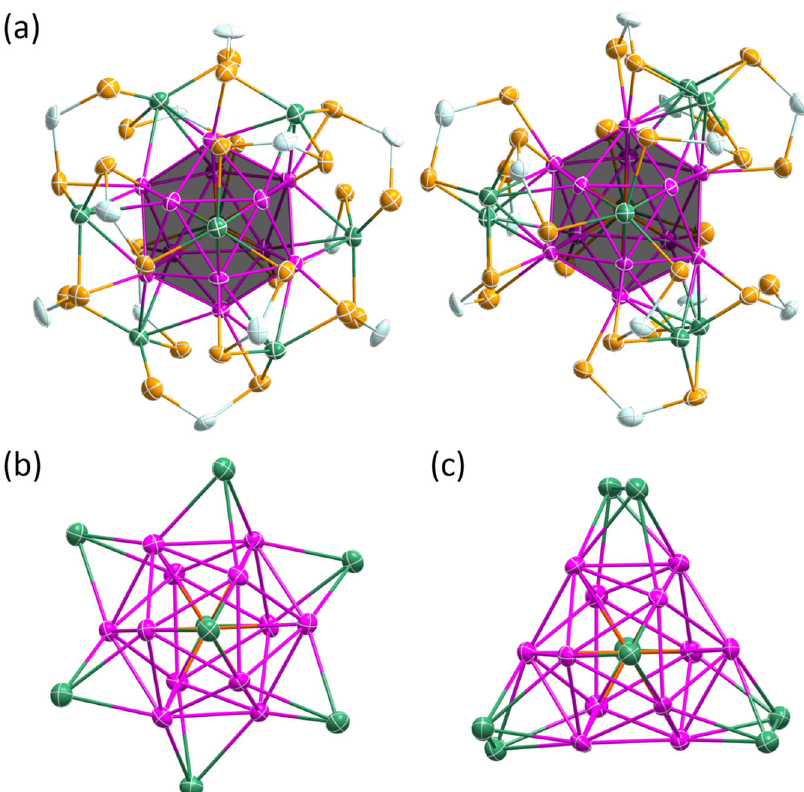
Fig. 5 The molecular structure of 3a and 3b. a The two co-crystallized structures of [PdAg 20 {Se 2 P(O i Pr) 2 } 12 ], 3a (left) and 3b (right). Isopropoxy groups have been omitted for better clarity. b The T h Pd@Ag 20 metallic core of 3a . c The C 3 Pd@Ag 20 metallic core of 3b . (color code. Pd: orange; Ag ico : blue, Ag cap : pink; Se: light orange; P: dark green).